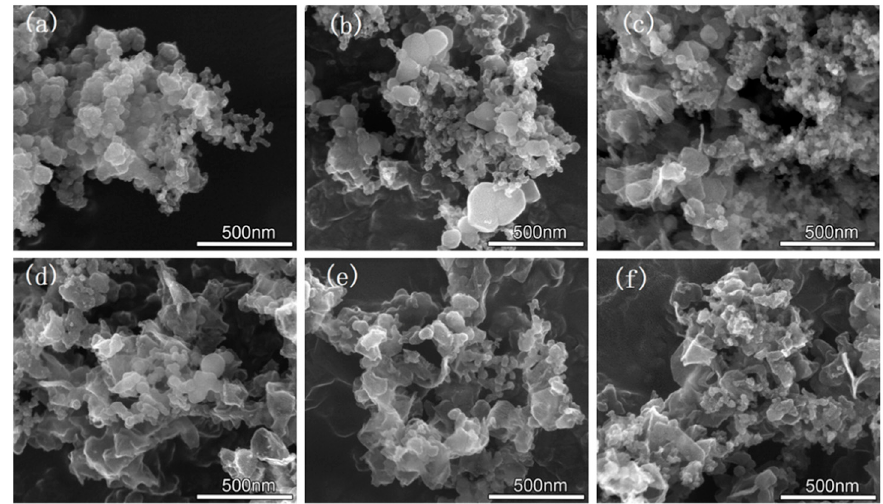
Figure 4. SEM images of the silicon-carbon nanocomposite prepared with different hydrogen/methane ratios. ( a ) No hydrogen, ( b ) 1:20, ( c ) 1:10, ( d ) 1:5, ( e ) 1:3, ( f ) 1:2.